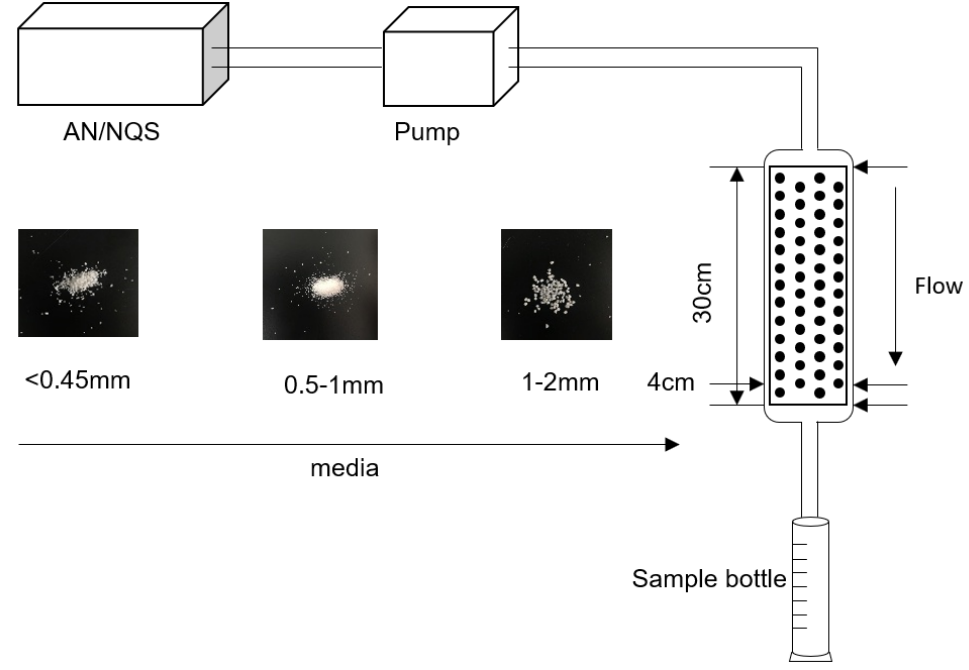
Figure 1. Sketch of experimental device. Table 1. Bimolecular reactive migration in porous